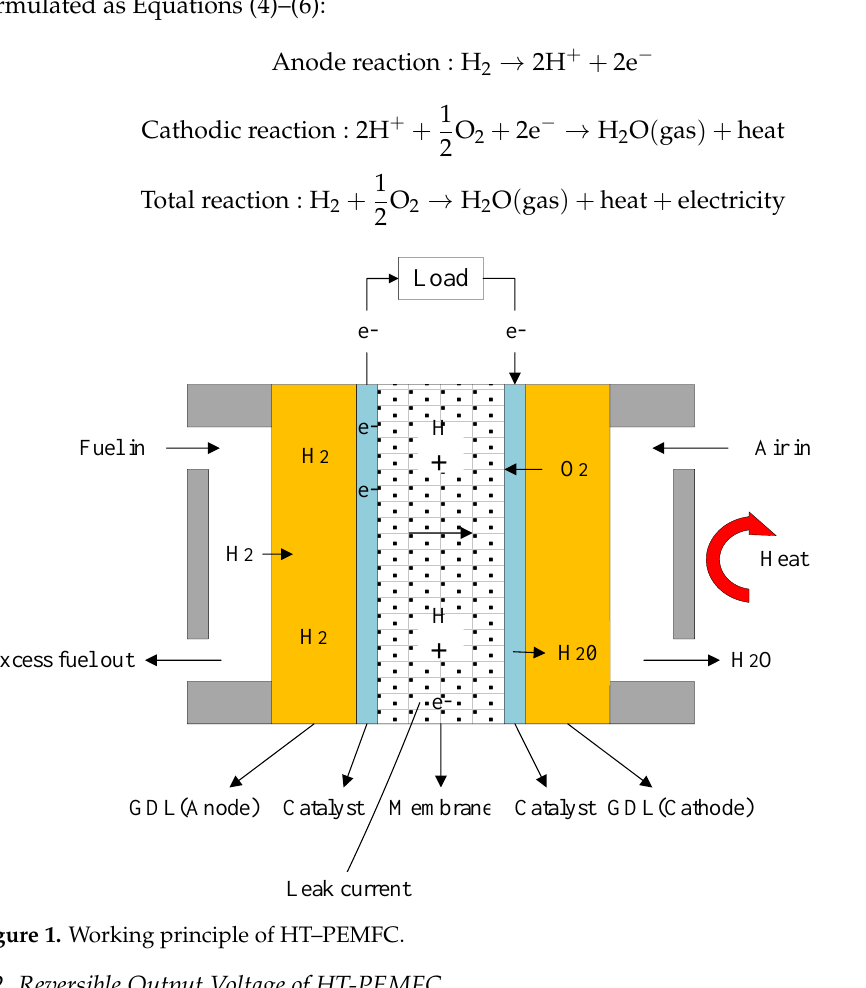
Figure 1. Working principle of HT – PEMFC.